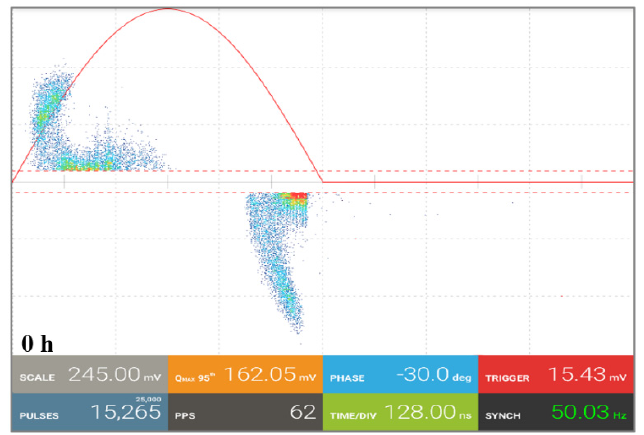
Figure 6. DCP voltage PRPD patterns with δ = 0, acquired after a few minutes of voltage application.